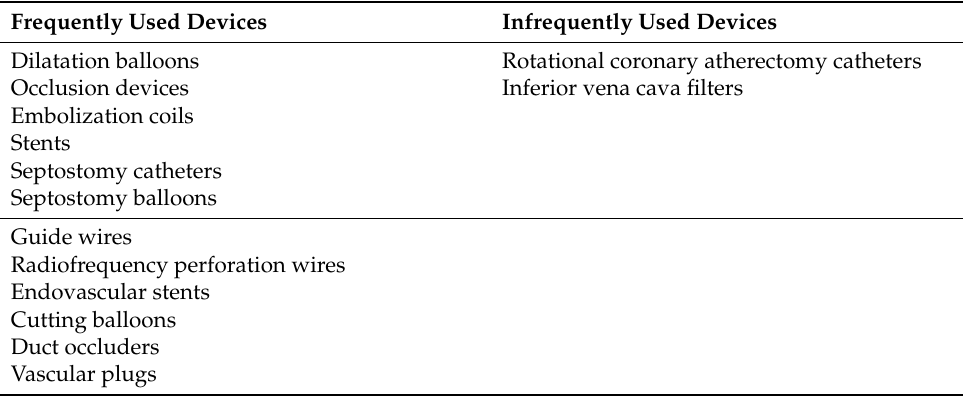
Table 1. Frequency of the use of specific types of devices